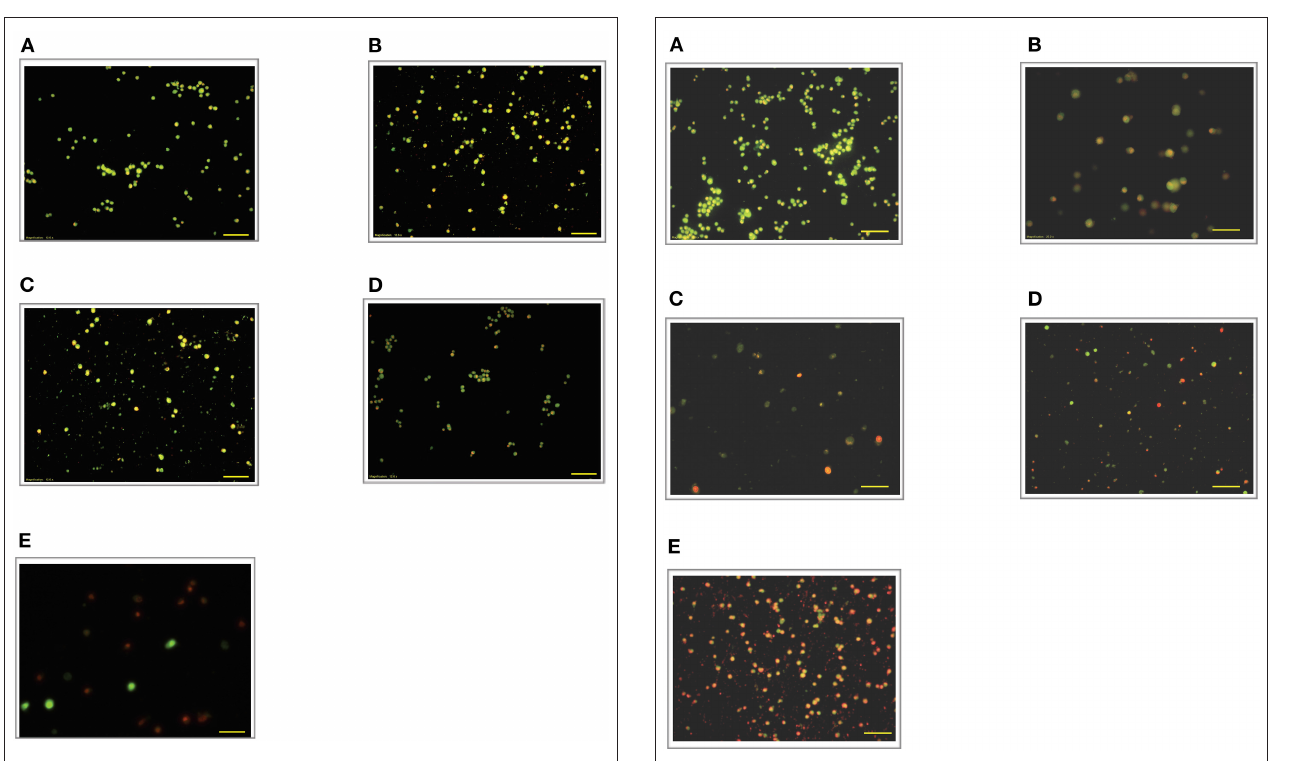
FIGURE 7 | Acridine orange and propidium iodide nucleic acid binding dyes in LPS-stimulated cells. Cells were stimulated with 12 µ g/mL LPS for (A) . Control, (B) . 12, (C) . 24, (D) . 48, and (E) . 72h. Cells were stained with AO/PI to examine their morphological changes, where the green color represents AO, which stains live and dead nucleated cells while the red color represents PI, which stains dead nucleated cells. Representative fluorescence images from inverted fluorescence microscope. Field of views for each time point from three independent experiments. The cells lost membrane integrity with orange-reddish color, indicating late apoptosis; red cells indicate necrosis. Pictomicrographs were taken with original magnification (10 × ); the scale bar represents 100 µ